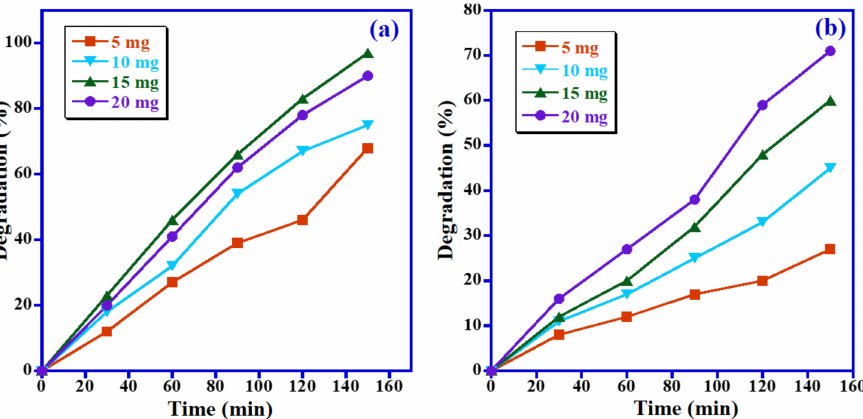
Figure 10. Influence of catalyst quantity on photodecomposition of ( a ) MB and ( b ) MO.